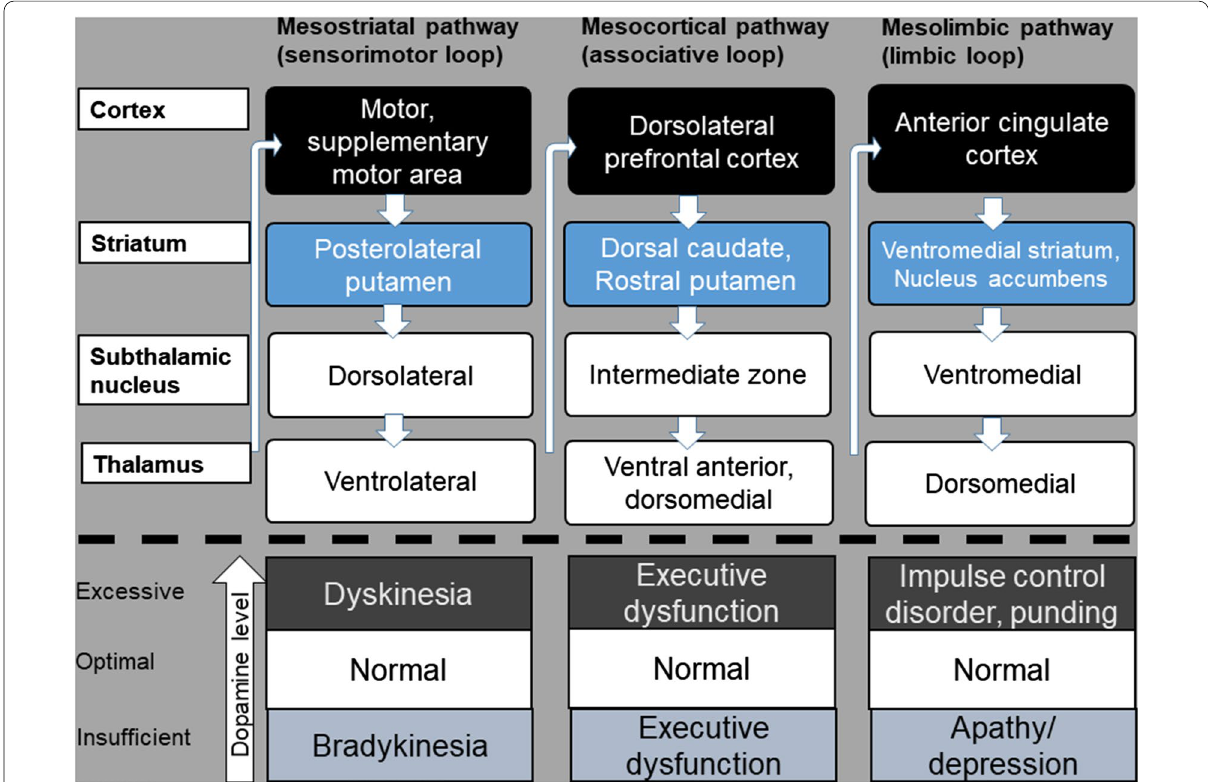
Fig. 1 Triadic parallel cortico-striatal-pallido-thalamo-cortical loop and the clinical relevance in relation to the striatal dopamine level (modified from Rowe et al. (2019) and Volkmann et al.